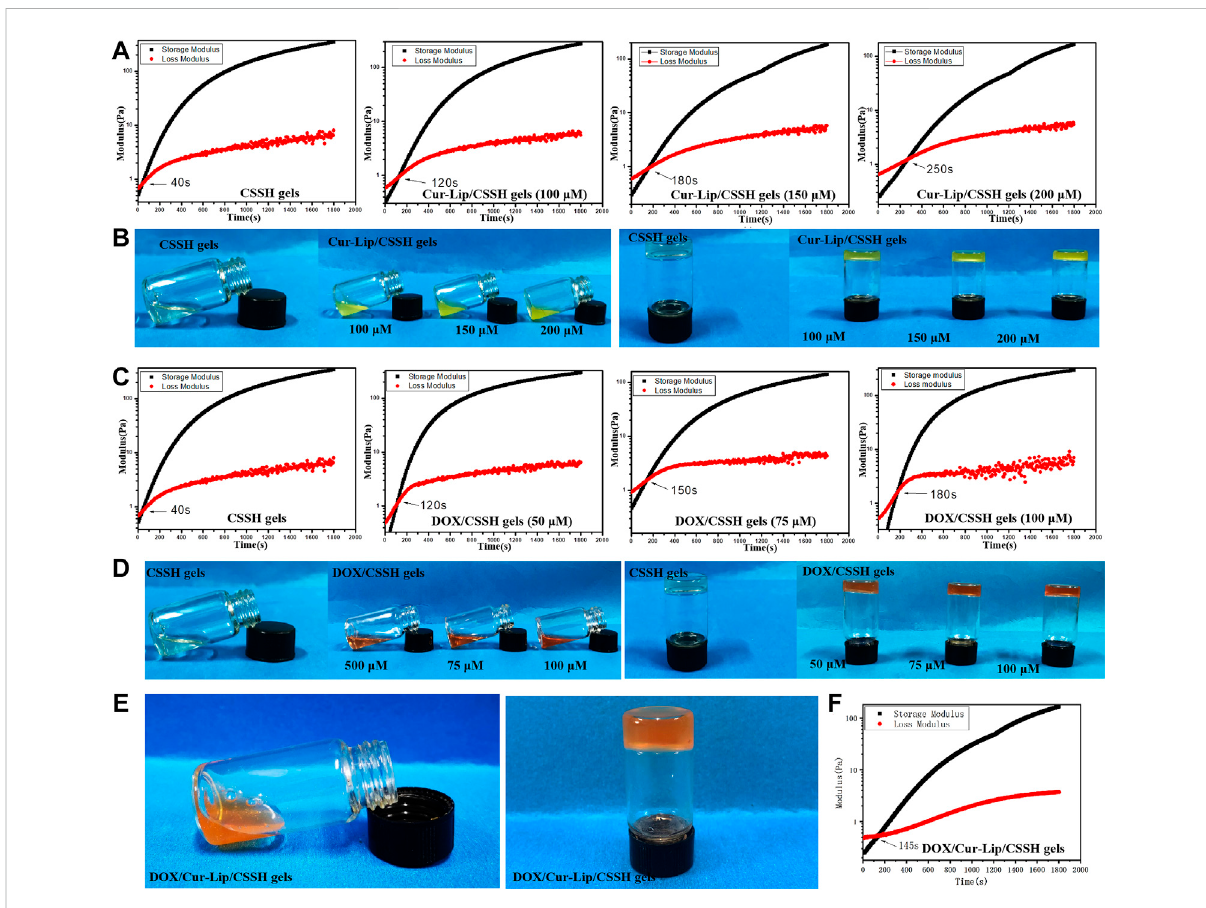
FIGURE 6 Gelation time and gelation point of the drug-loaded hydrogels measured using vial inversion (B,D,E) and rheology analysis (A,C,F)